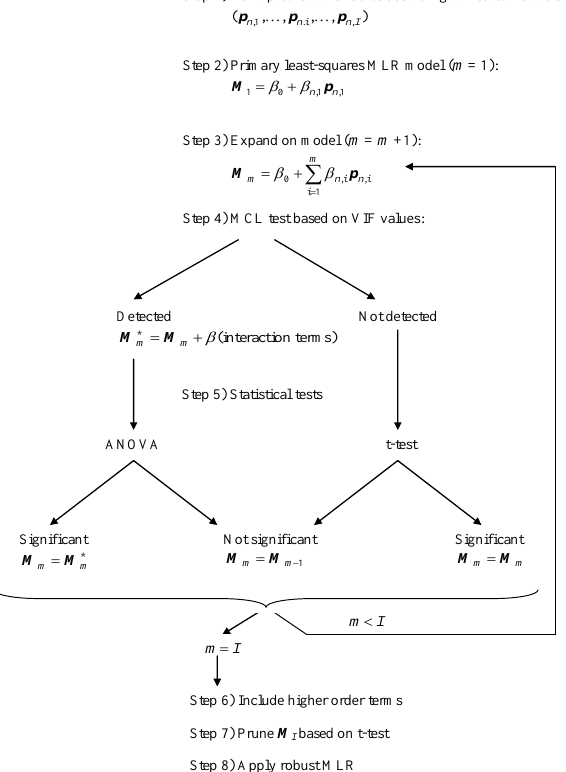
Fig. 2. Schematic diagram of our robust forward MLR